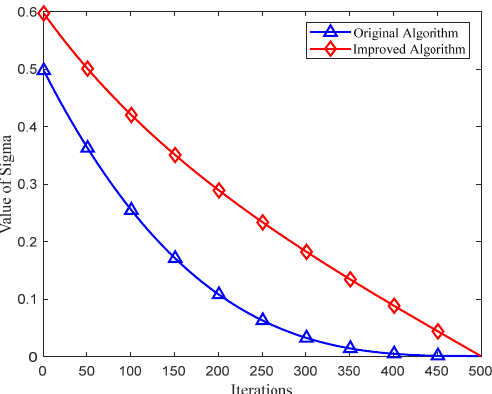
Figure 1. Comparing the standard deviation of the improved weed algorithm with that of the orig- inal algorithm.